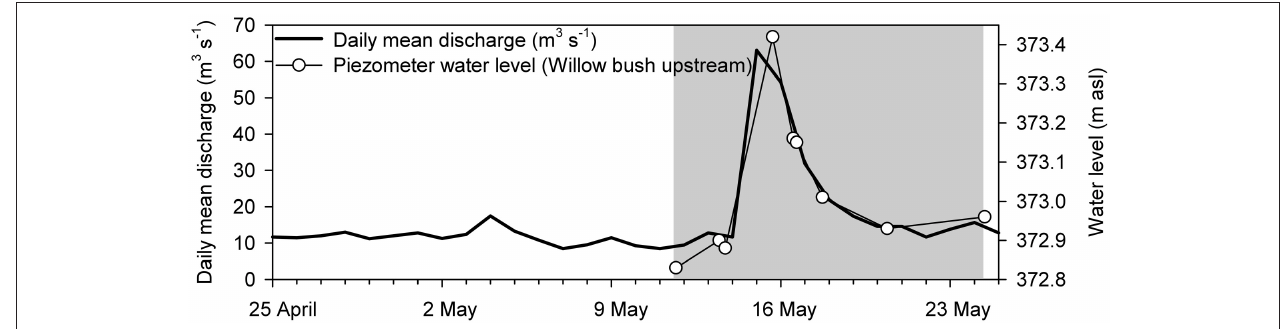
FIGURE 2 | Daily mean discharge of the River Thur and water level changes in the willow bush zone during the course of the sampling campaign in 2011 (http://www.hydrodaten.admin.ch/de/2044.html?). Water level changes in the other zones were highly similar to the ones presented here and ranged from 0.59 to 0.68 m. The gray area indicates the monitoring period from 11 to 24 May 2011. The peak of the flood event occurred on 15 May